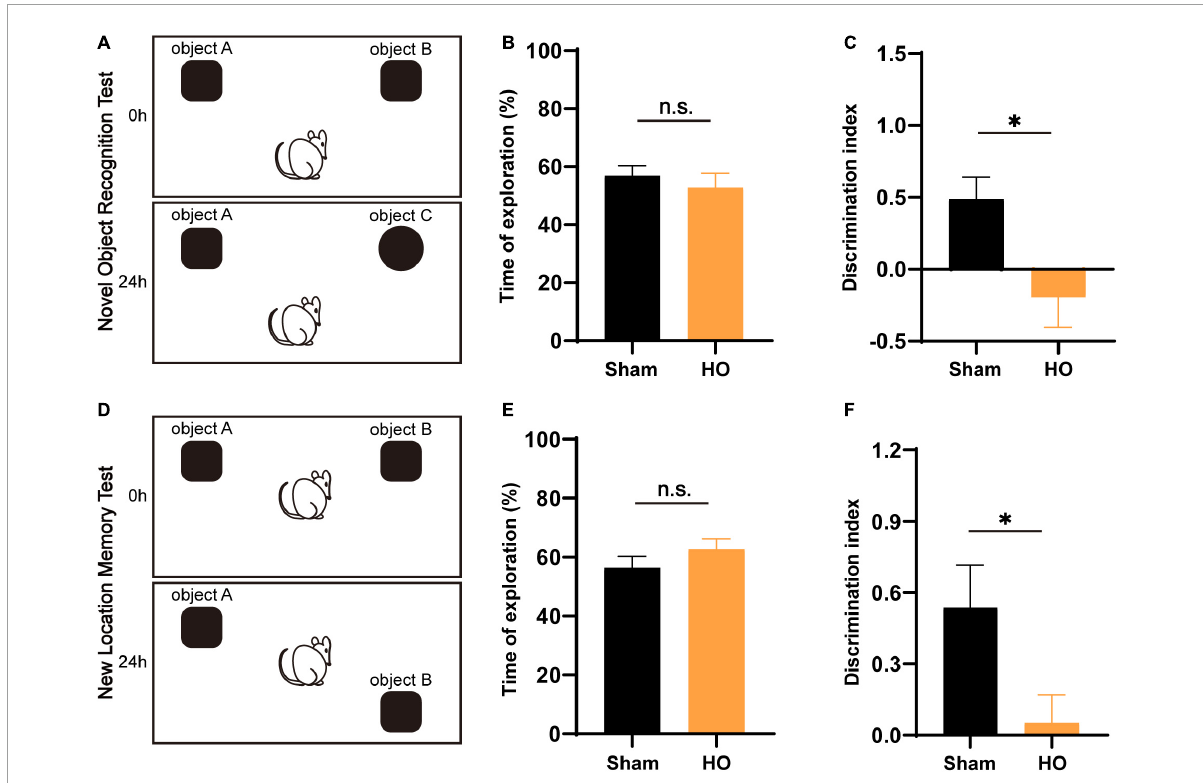
FIGURE3 Effects of lesions on recognition memory assessed by the NOR test and NLM test. (A) Schematic diagram of the novel object recognition (NOR) test setup. (B,C) Total exploratory time (%) and recognition index (%) in each group, n = 6, ∗ P < 0.05 vs. the sham-operated group. (D) Schematic of the novel location memory (NLM) test setup. (E,F) Total exploratory time (%) and recognition index (%) in each group, n = 6, ∗ P < 0.05 vs. the sham-operated group. All data are presented as the M ± SEM of each